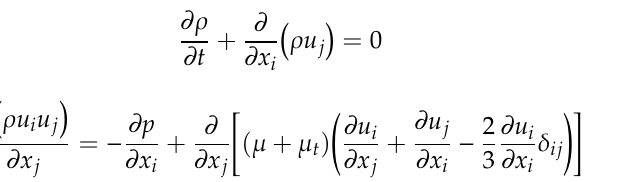
Table 2. Grid cells of the selected mesh.